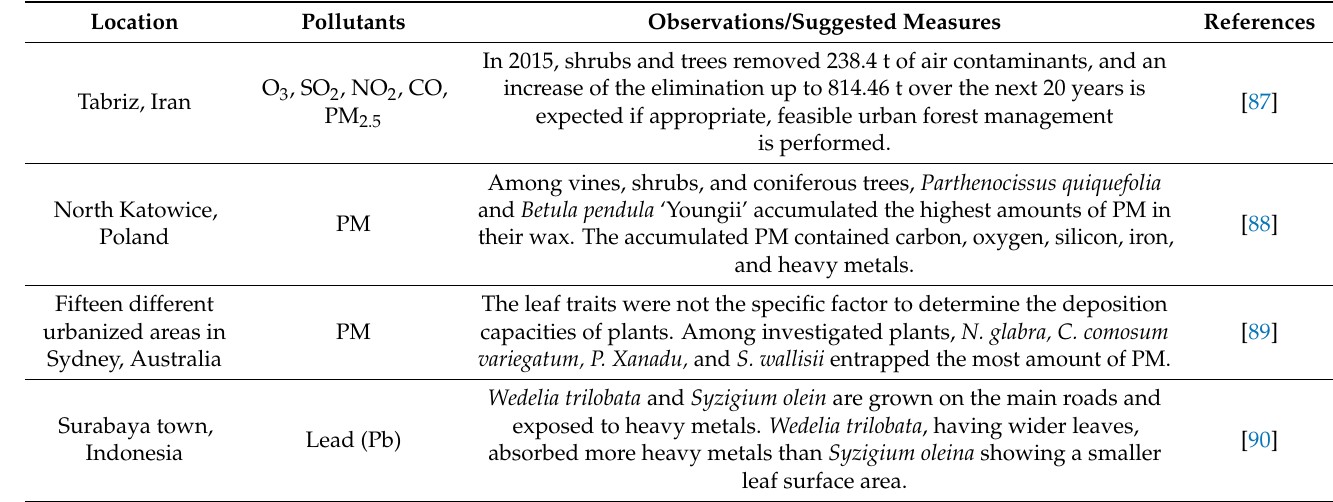
Table 3. Phytoremediation for improving outdoor air